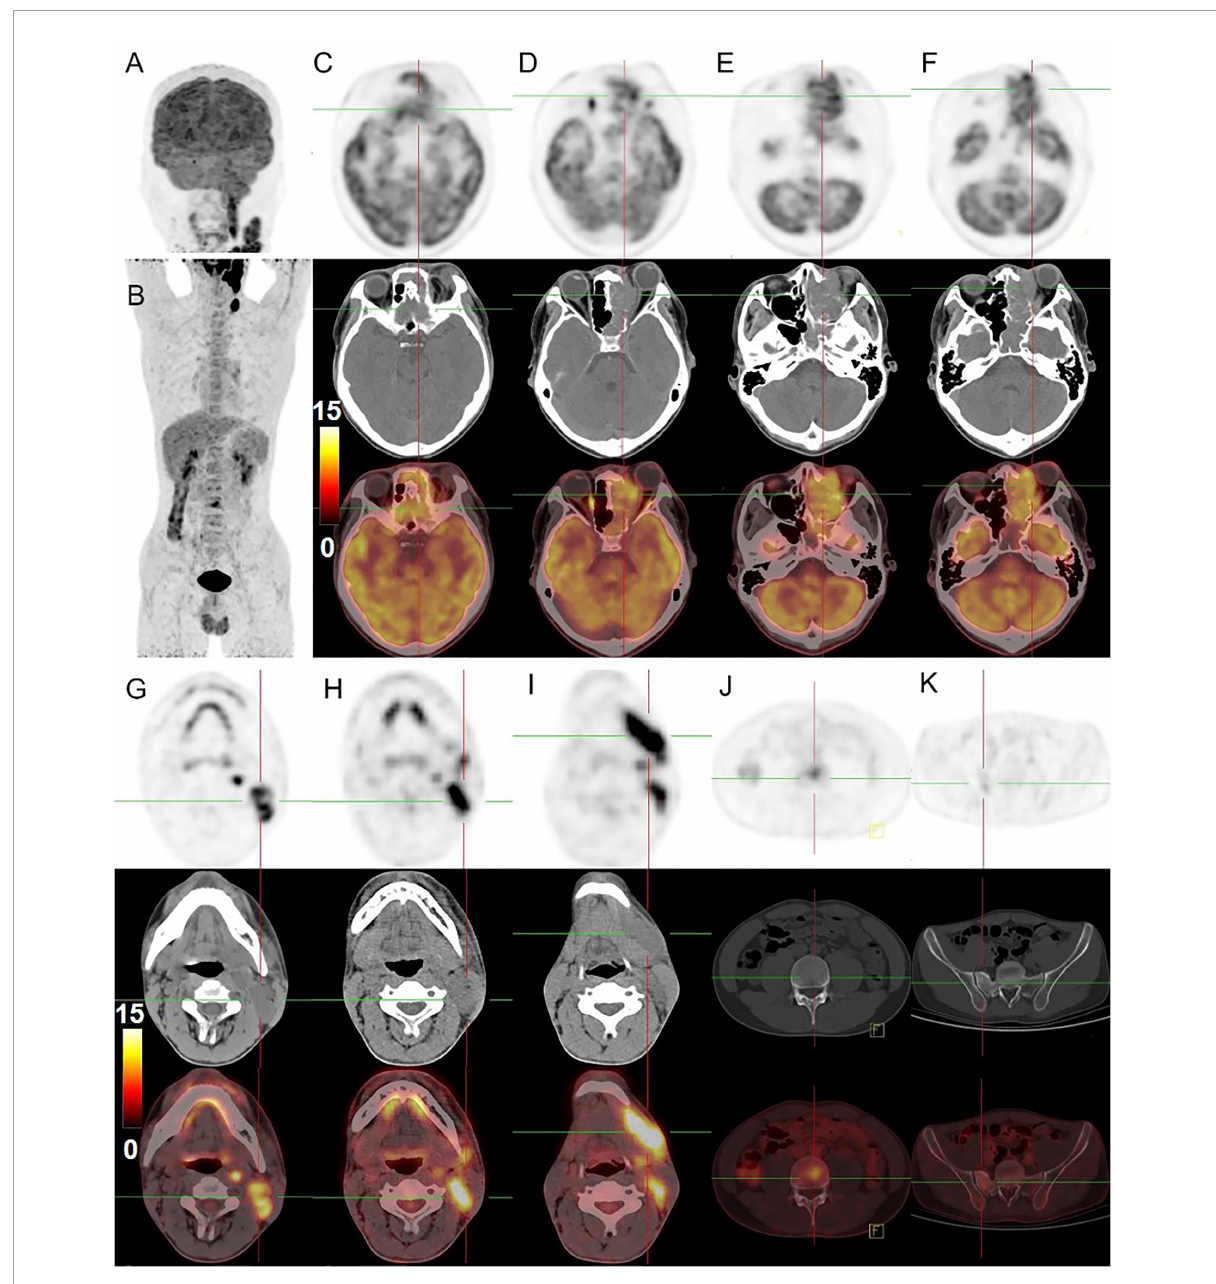
FIGURE3 18 F-FDG PET/CT images of nasal sinus ARMS in case 1. (A,B) The anteroposterior 3-dimensional maximum intensity projection image (MIP) demonstrated hypermetabolic lesions in the maxillofacial, neck region, 3rd lumbar vertebra, and the right sacrum. (C–F) The transverse images showed bilateral frontal sinus and left ethmoidal sinus, sphenoidal sinus, maxillary sinus, and nasal cavity filled with soft tissue shadows, with increased FDG uptake at a SUVmax of 12.6 and maximum section of about 4.1 cm × 4.6 cm. The lesion was shown with unclear boundaries from the adjacent structures. (G–I) The transverse images showed multiple enlarged lymph nodes in the left parapharyngeal regions and left cervical regions I-IV with significantly higher uptake of SUVmax about 18.6, a larger one was measured at 1.8 cm × 1.6 cm. (J,K) The transverse images showed the 3rd lumbar vertebra and the right sacrum with dense foci of radioactive distribution, SUVmax of about